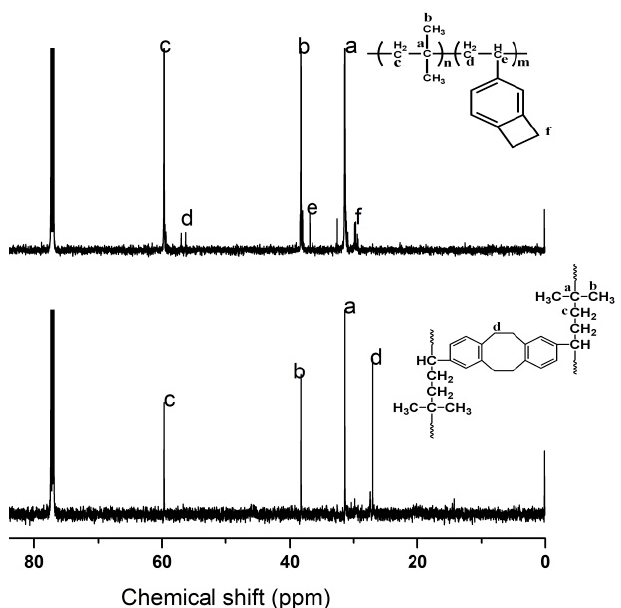
Figure 6. 1 H NMR spectra of the copolymer before thermal crosslinking ( top ) and after thermal crosslinking ( bottom ).